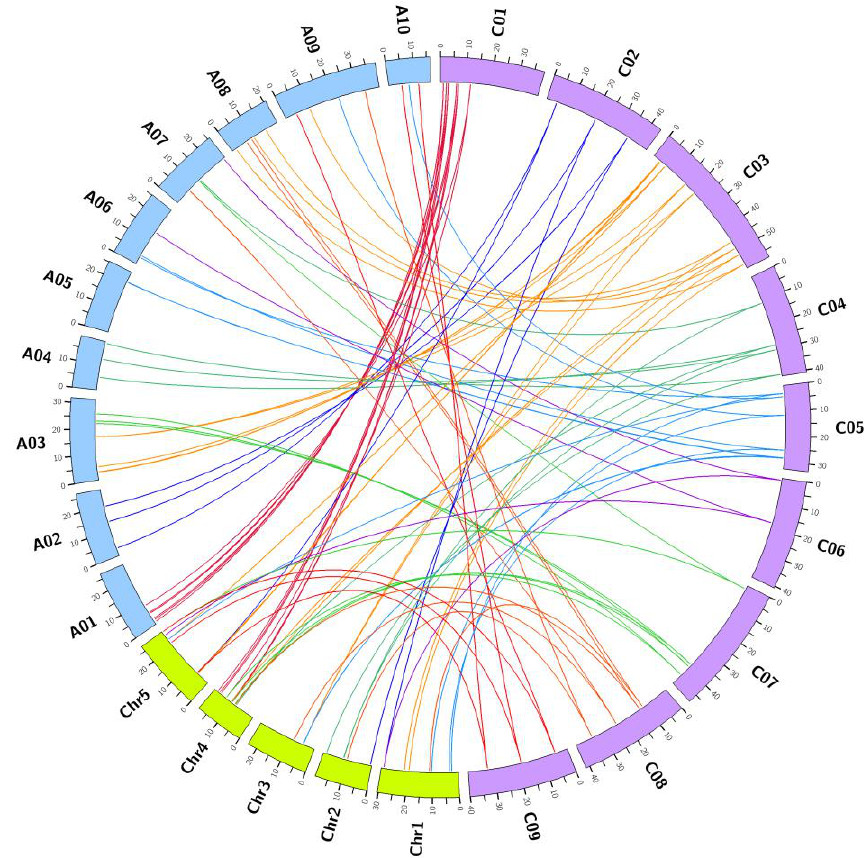
Figure 1. Circos diagram of syntenic carotenoid biosynthetic genes in B. oleracea , B. rapa , and A. thaliana . C01 to C09 indicate B. oleracea chromosomes, A01 to A10 indicate B. rapa chromosomes, and Chr1 to Chr5 indicate A. thaliana chromosomes.